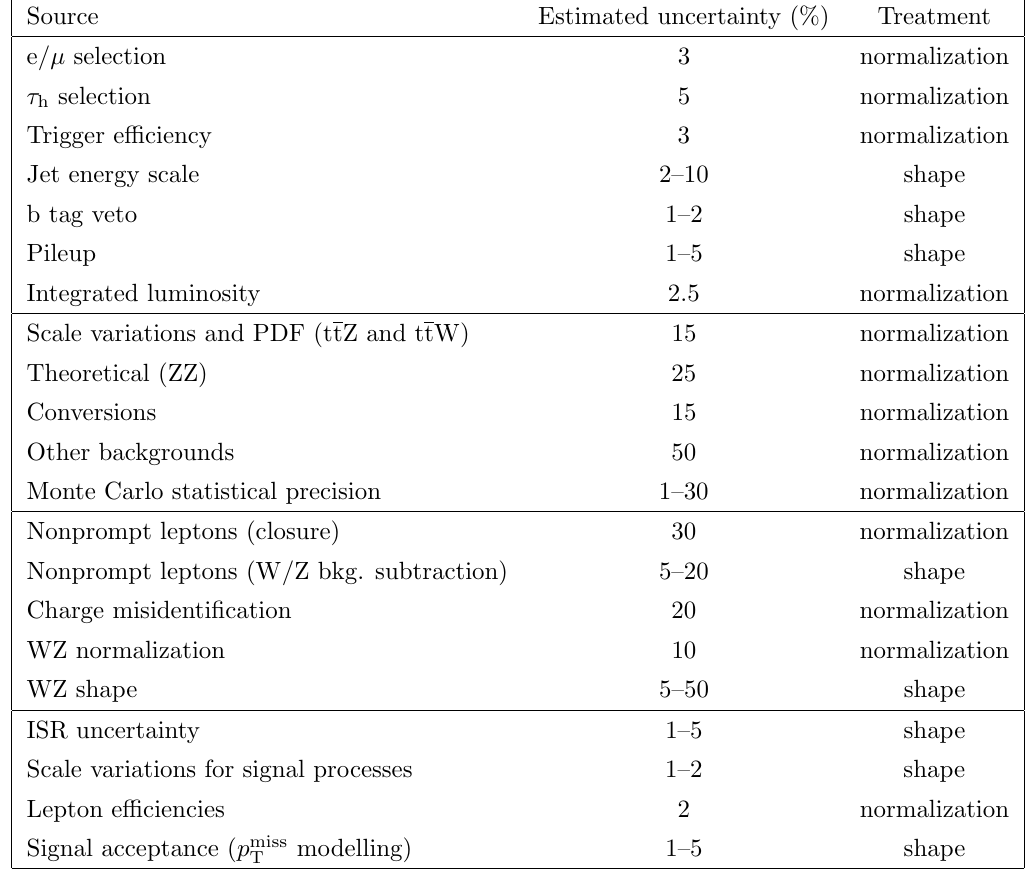
Table 10 . Summary of systematic uncertainties in the event yields in the search regions and their treatment. Uncertainties are allowed to vary only the normalization of all the bins at once, or both the shape and the normalization (allowing for di(cid:11)erent correlations across the bins). The upper group lists uncertainties related to experimental e(cid:11)ects for all processes whose yield is estimated from simulation; the middle group lists uncertainties in these yields related to the event simulation process itself. The third group lists uncertainties for background processes whose yield is estimated from data. Finally, the last group describes uncertainties related to the extraction of the signal acceptance in MC